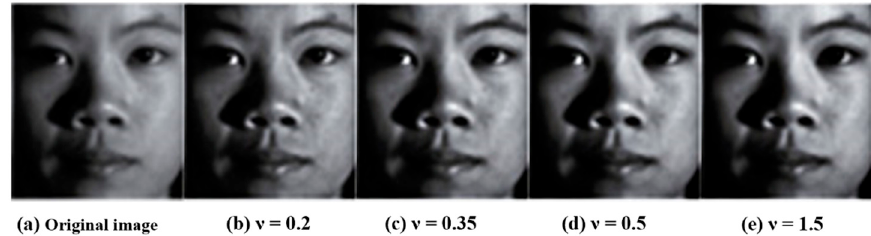
Figure 5. A-F character of fractional order.